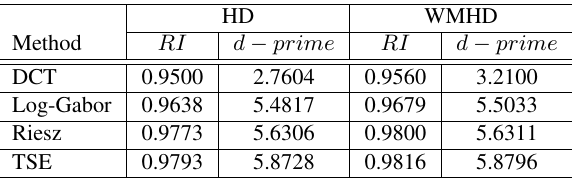
prime values obtained by different filters Table 3. RI and d  and two distance measures HD and WMHD, on IITD